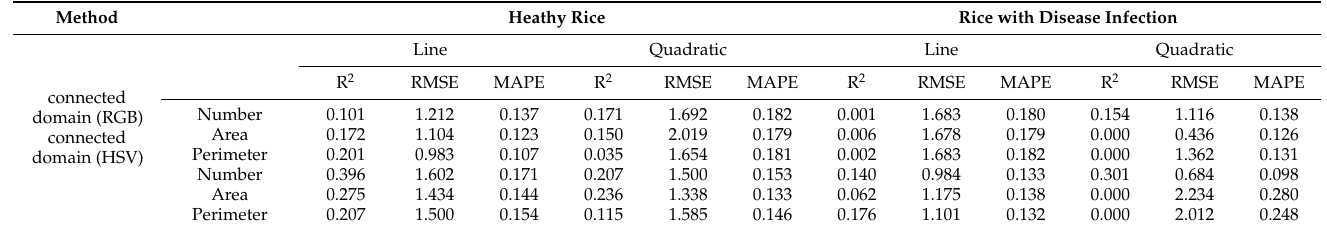
Table 2. Coefficient of determination (R 2 ), root mean square error (RMSE), and mean absolute percentage (MAPE) for regression between mature rice density and connected